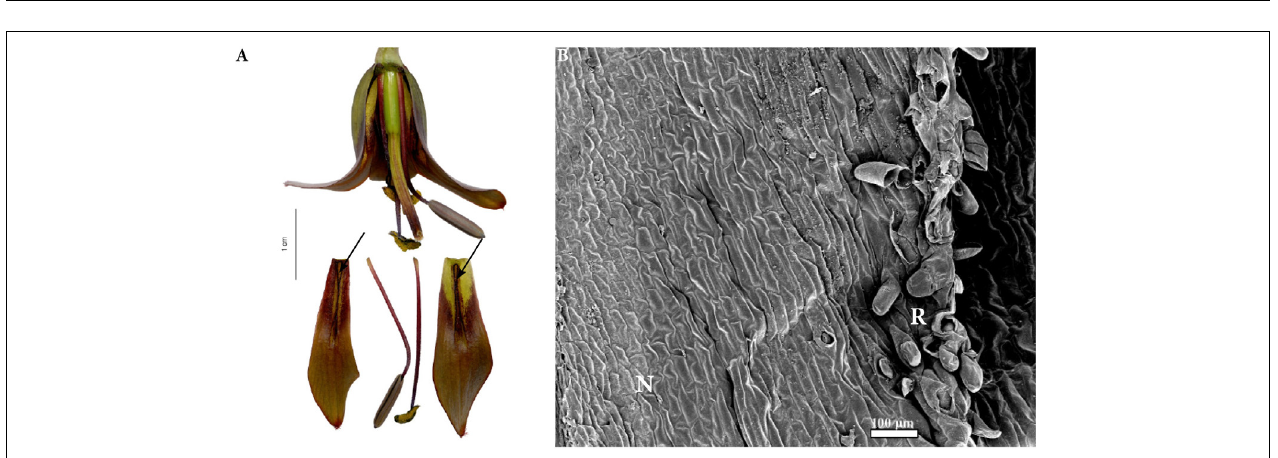
FIGURE 7 | Flowers and nectaries of F. sewerzowii . Macro and SEM images. (A) Flowers and tepals, nectaries marked with arrows. (B) Part of outer tepal showing the nectary (N), surrounded by papillose ridges (R).